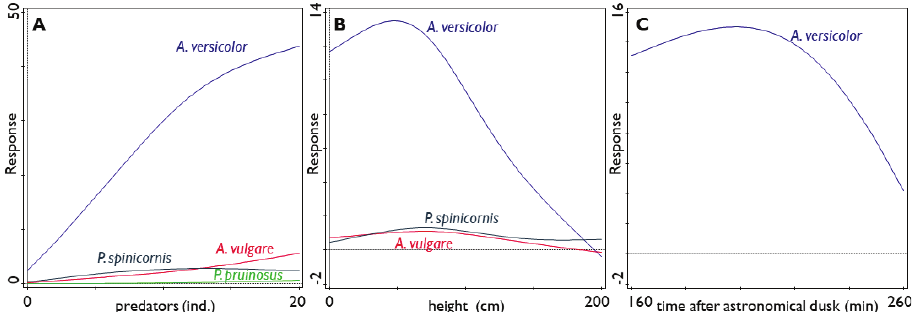
Figure 6. Significant response (see Table 1) of terrestrial isopod numbers per species to A number of predators B height on the wall C time after dusk during a 90 min interval in October